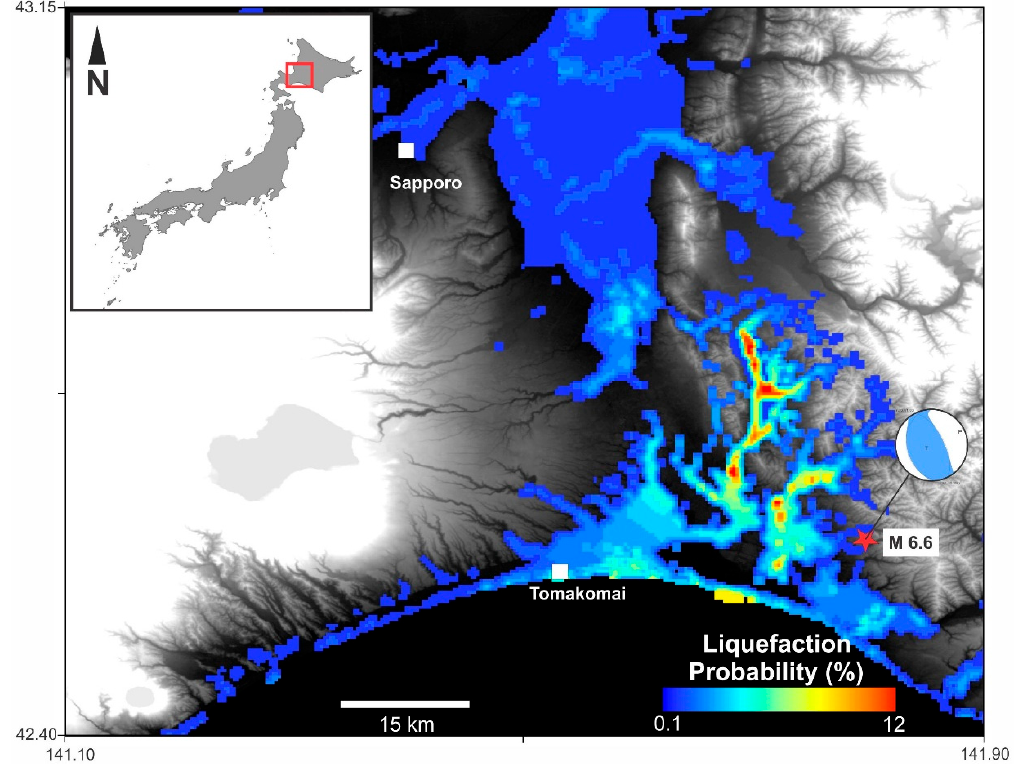
Figure 1. Liquefaction probability (LiquickMap) after the Hokkaido Eastern Iburi earthquake (M 6.6) on 6 September 2018. Liquefaction probability in colorful areas (blue to red) is between 0.1 and 12 percent, while black and white regions have zero percent probability of liquefaction.